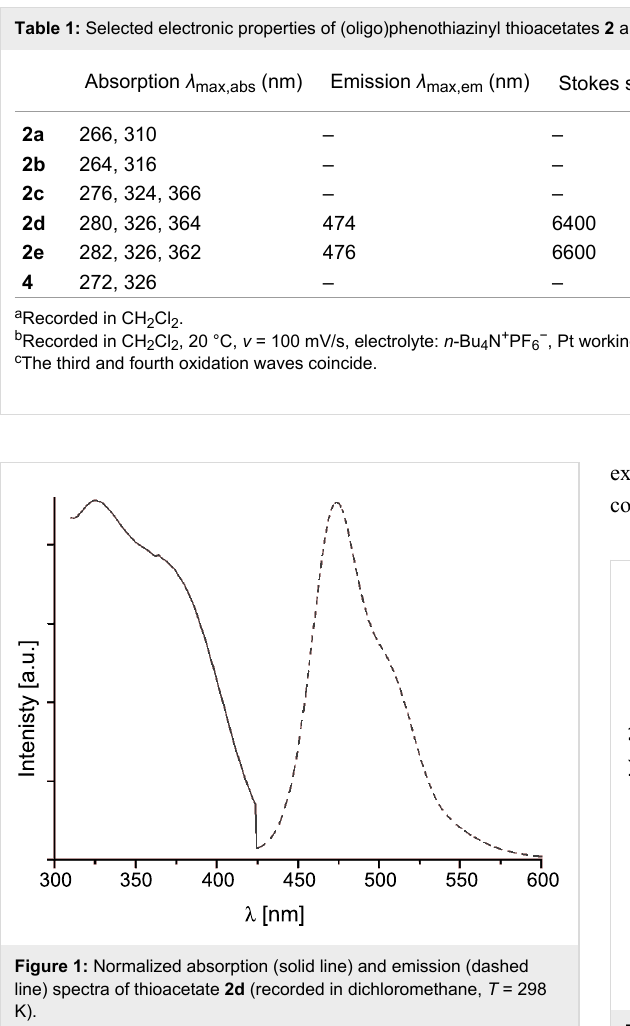
Figure 2: Cyclic voltammogram of thioacetate 2d (recorded in CH 2 Cl 2 , T = 293 K; 0.1 M electrolyte [Bu 4 N][PF 6 ]; ν = 100 mV/s; Pt-working electrode, Ag/AgCl-reference and Pt-counter